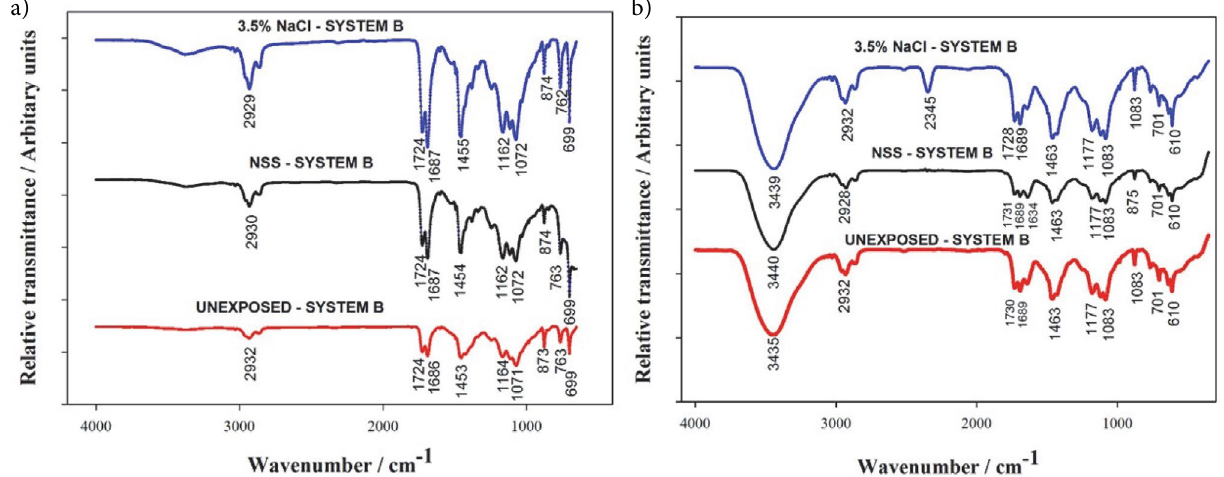
Figure 7. Spectra for system B before and after exposure to NSS and 3.5% NaCl tests obtained a) by the ATR FTIR method and b) from KBr pellets containing the scraped powder form the sample